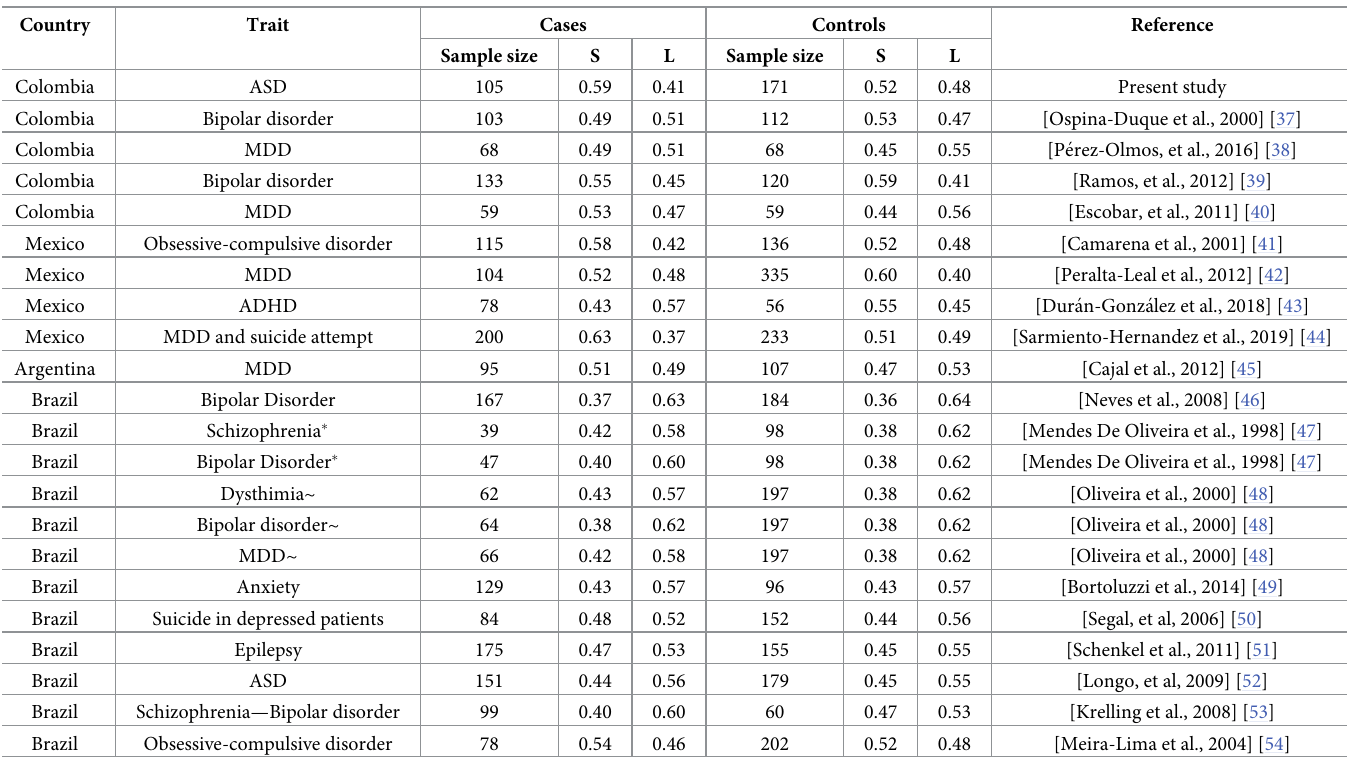
Table 3. Allelic frequencies reported in Latin American population.